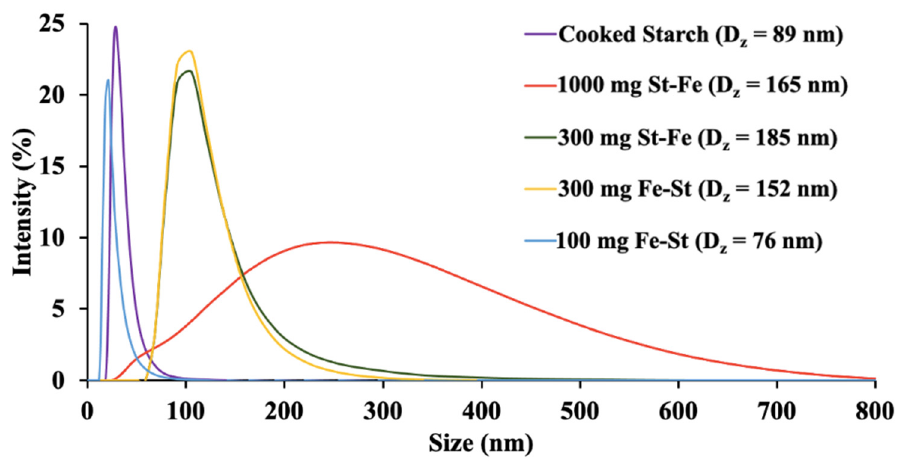
Figure 1. Dynamic light scattering measurements of starch-stabilized iron oxide nanoparticles. TEM imaging (Figure 2) confirmed the presence of iron (Fe 2+/ Fe 3+ ) oxide NPs embed- ded within the starch matrix. In the images, the dark spots/shaded areas are due to